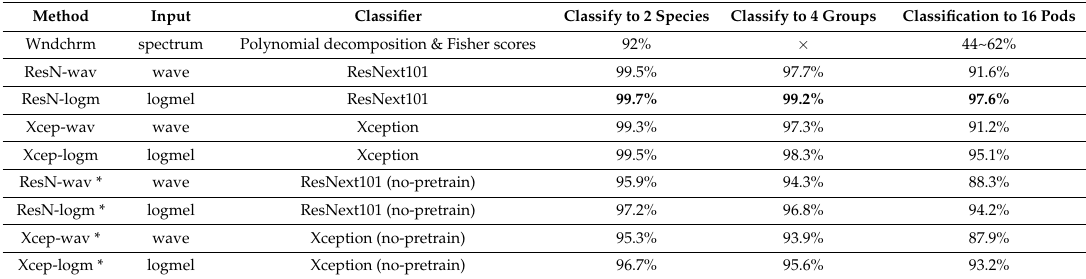
Table 2. Comparison of classification results.